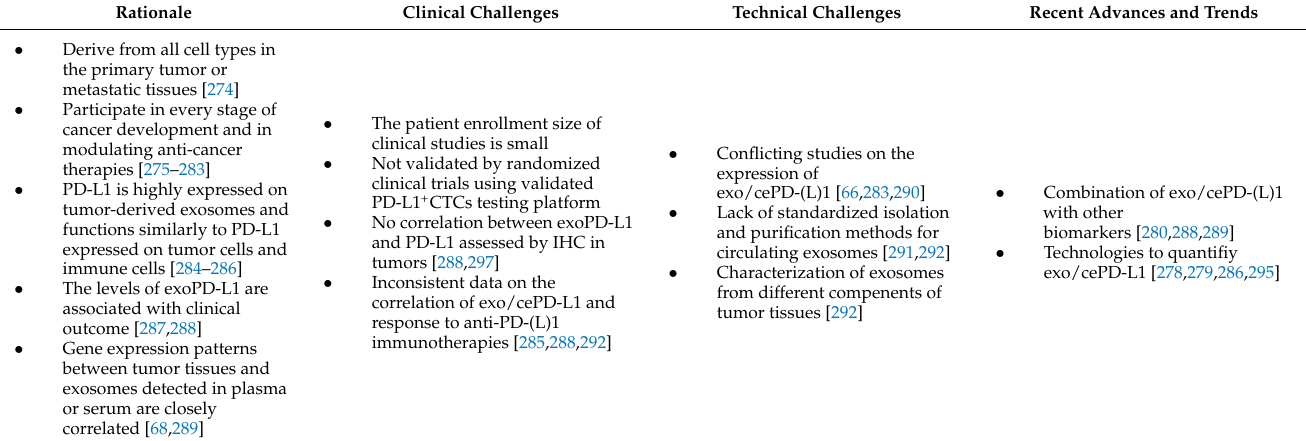
Table 3. Clinical and technical challenges in the use of cePD-L1 as a biomarker for anti-PD-(L)1